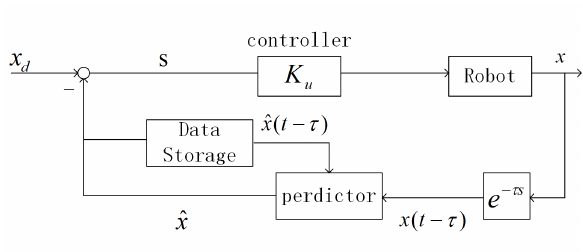
Figure 2. Block diagram of proposed predictor–controller